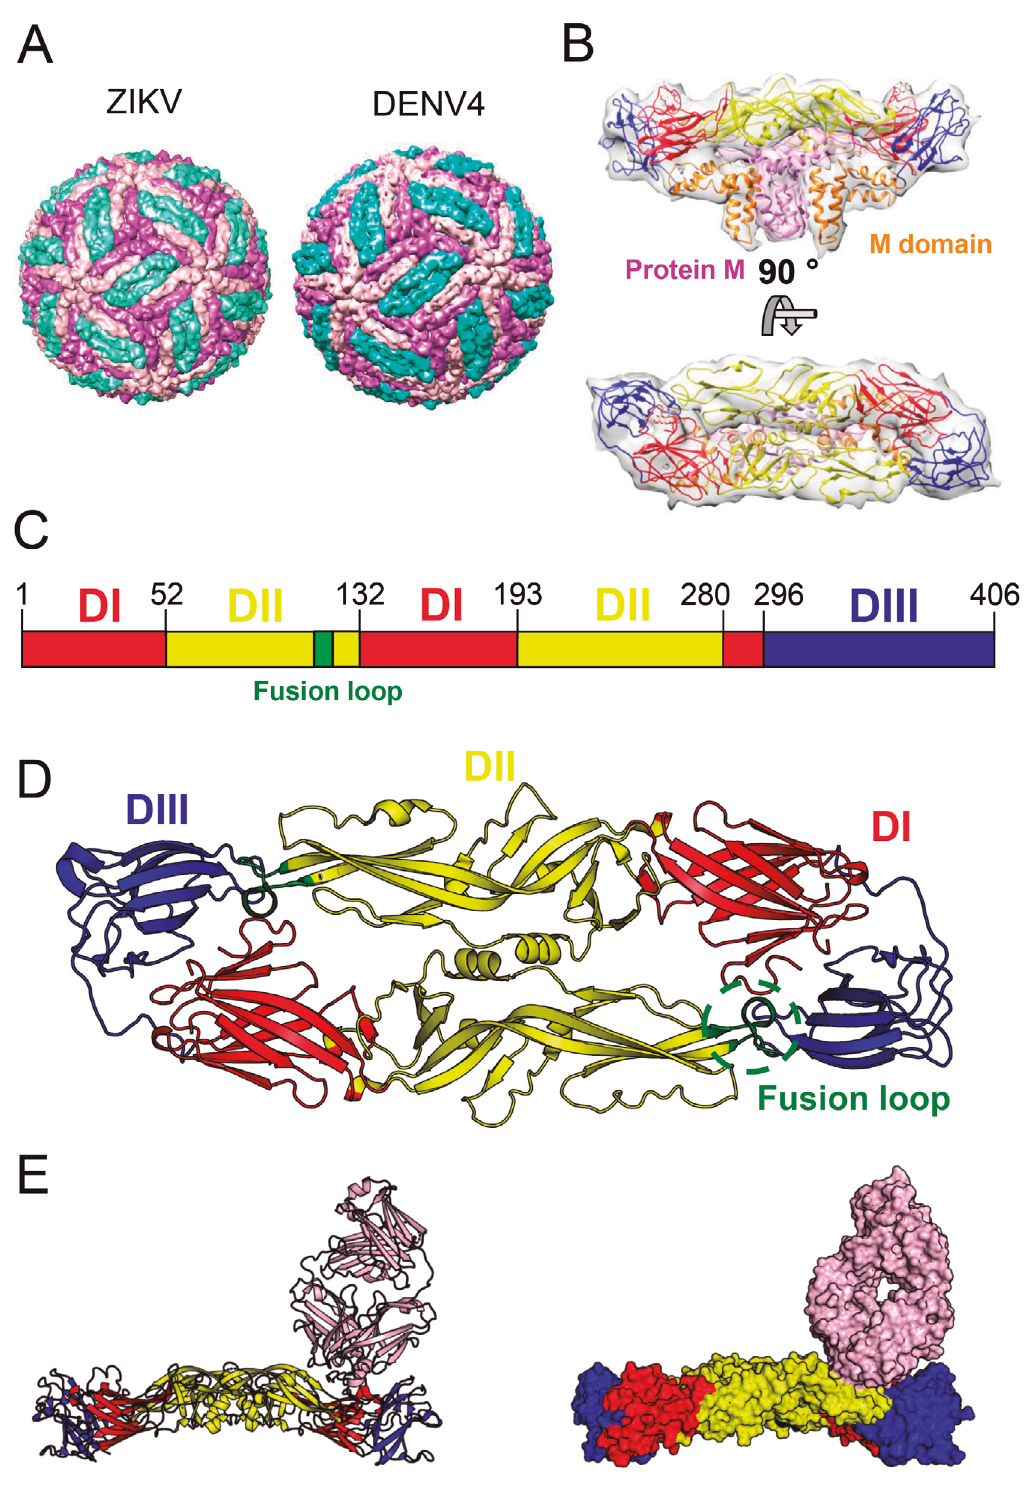
Figure 1. (A) CryoEM structure of ZIKV (PDB ID: 5IZ7) and DENV4 (PDB ID: 4CBF). (B) Model of protein E and protein M based on Cryo-EM density maps (PDB ID: 5IZ7). (C) Schematic domain organization of the ectodomain of ZIKV protein E. (D) Structure of ZIKV protein E dimer (PDB ID: 5JHM) and its three domains. (E) Structure of ZIKV-antibody complex (PDB ID: